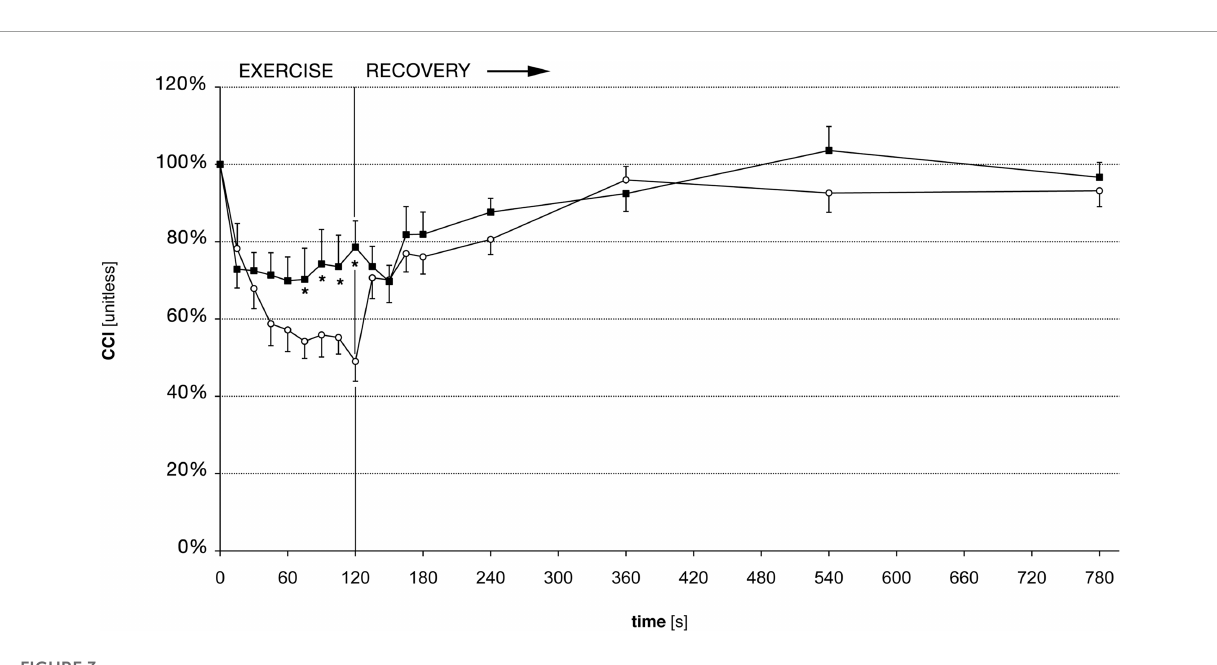
FIGURE 3 Central conduction index (CCI) before and after training. White circles: CCI before training, black squares: CCI after training. Error bars denote standard error of the mean. * denote statistically significant differences of CCI pre-to post-training (Wilcoxon signed rank test, p <